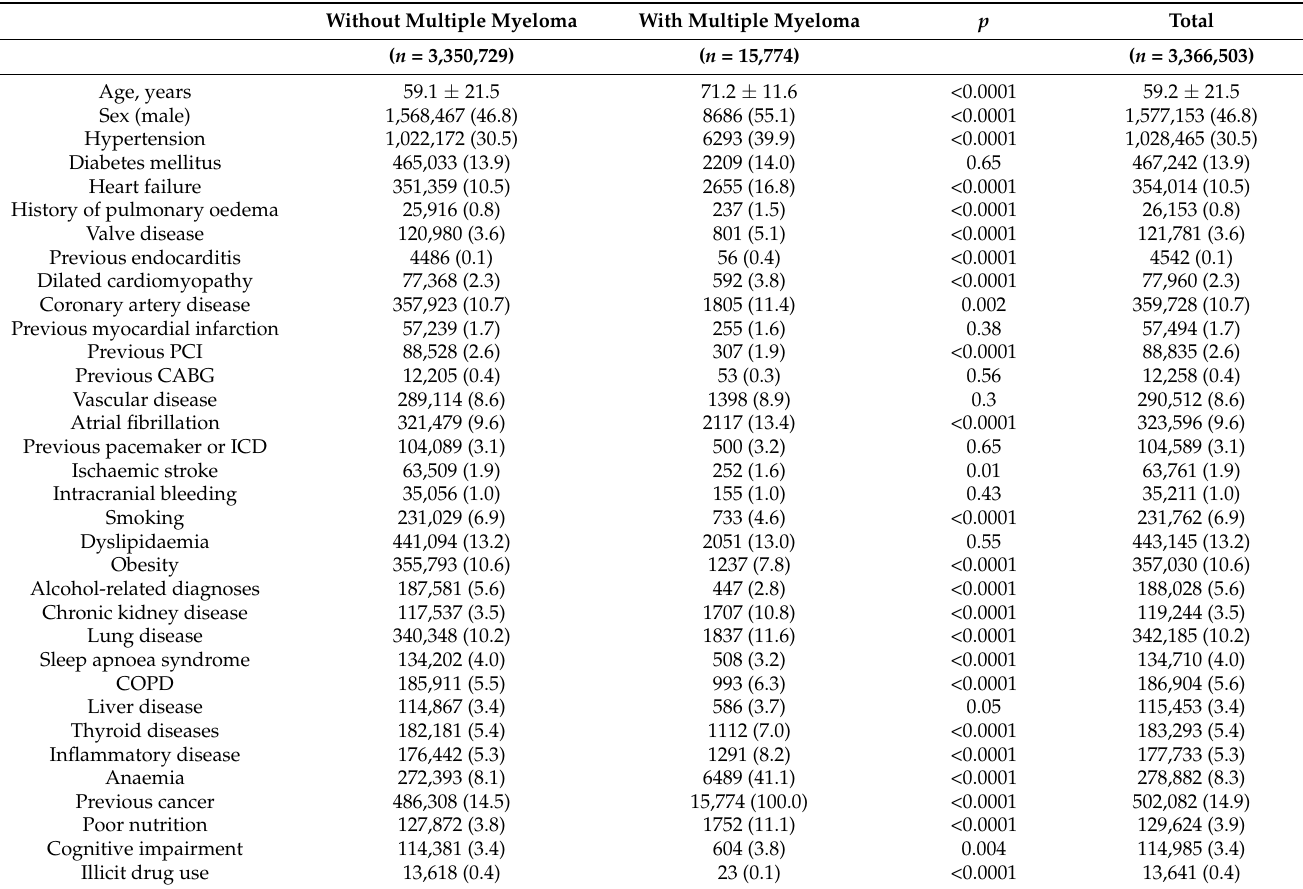
Table 1. Baseline characteristics of the unmatched population